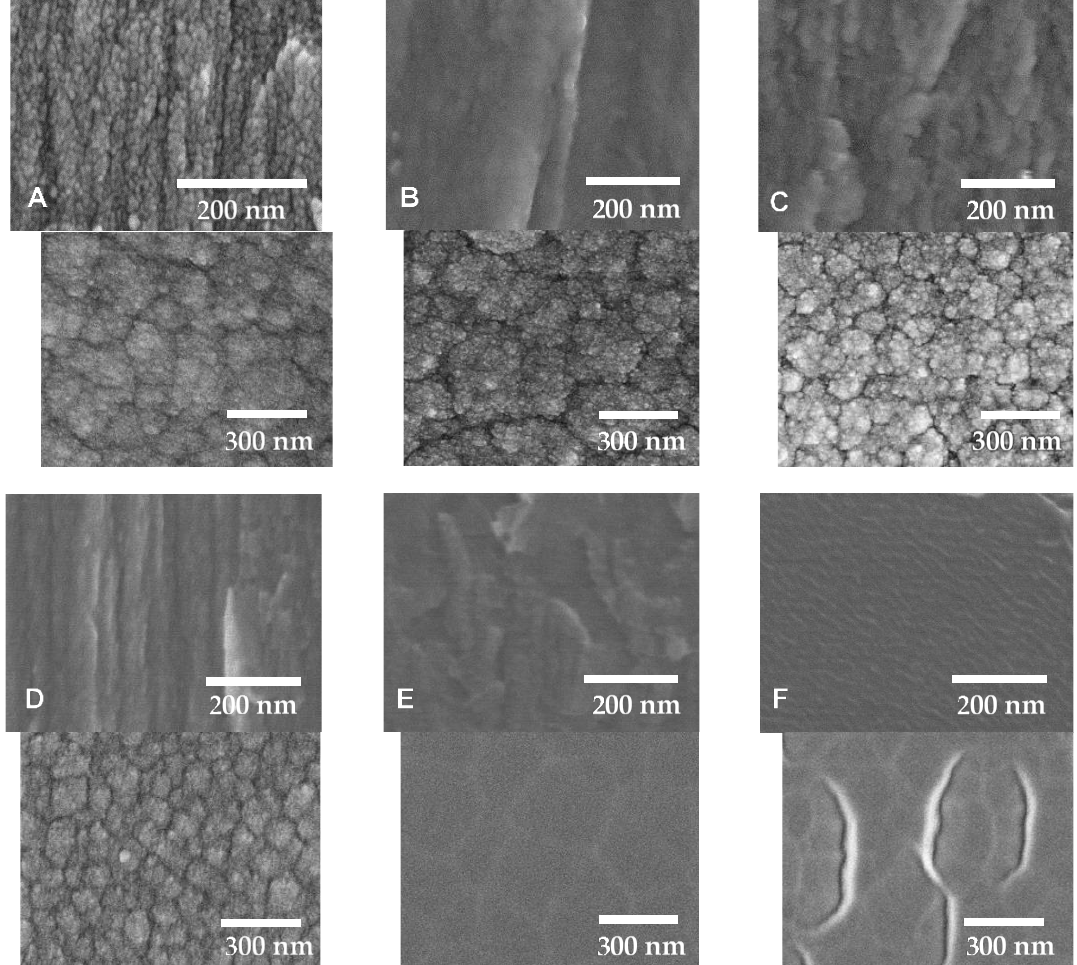
Figure 5. The top ( up ) and cross-sectional ( down ) SEM SE micrographs of Cr–C films deposited on Si (100) substrate at 0.8 Pa deposition atmosphere of ( A ) 9.1%, ( B ) 7.7%, ( C ) 6.7%, (D) 5.9%, ( E ) 4% and ( F ) 2.6% C 2 H 2 gas fraction with a substrate bias of −150 V.